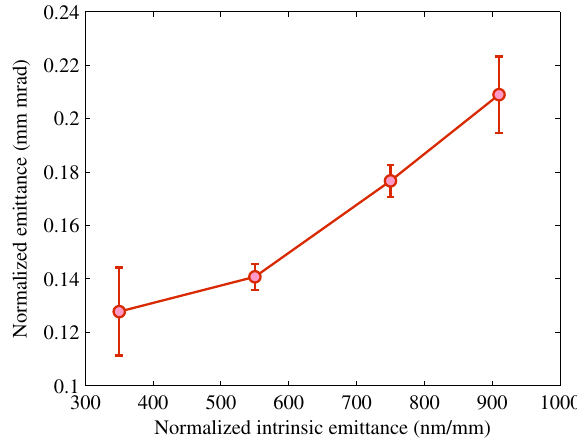
FIG. 14. Optimized emittance along the central part of the bunch at the end of the SwissFEL injector for 200 pC case versus the normalized intrinsic emittance. The error bars indicate the standard deviation of the emittance along a (cid:2) 1 mm interval in the